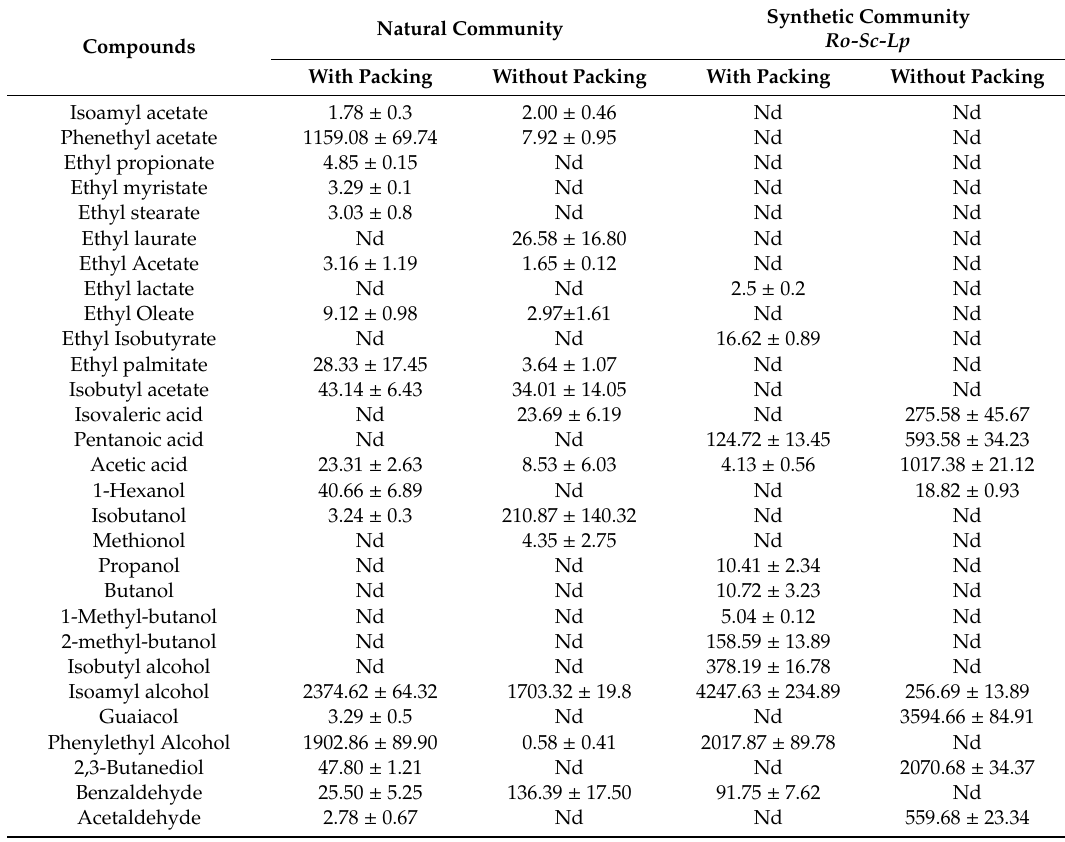
Table 3. Flavor compounds ( µ g / L) produced from natural community and combinations of strains as synthetic communities in a biofilm cultivation device with artificial rice